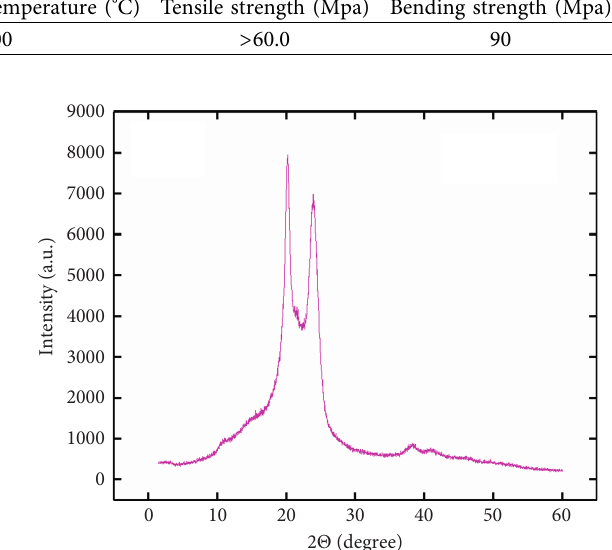
Figure 1: XRD testing results of the PA6